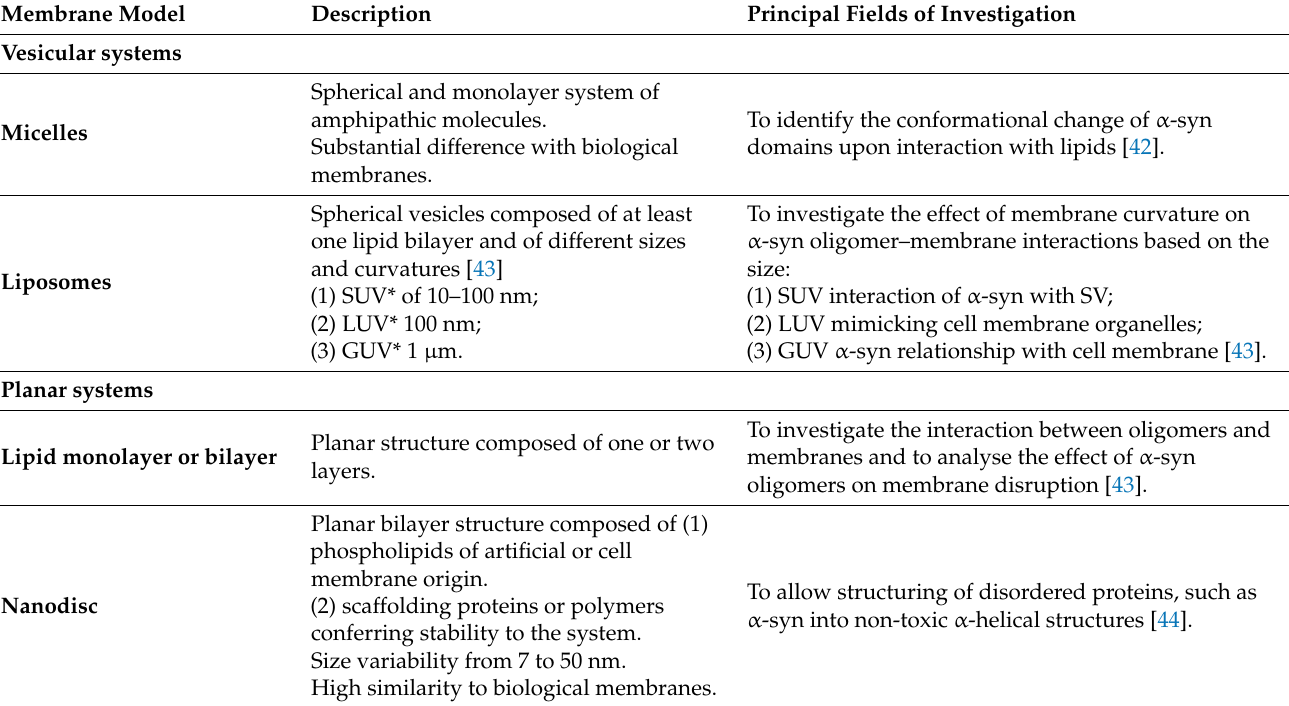
Table 1. Presentation of membrane models used to investigate the basic physical and biochemical role of α -synuclein ( α -syn). The artificial membrane systems are used to study the physical interaction of α -syn and lipids. They are classified into two categories according to their three-dimensional organisation: vesicular and planar models. These systems can be created using different types and proportions of phospholipids allowing the study of different binding properties of α